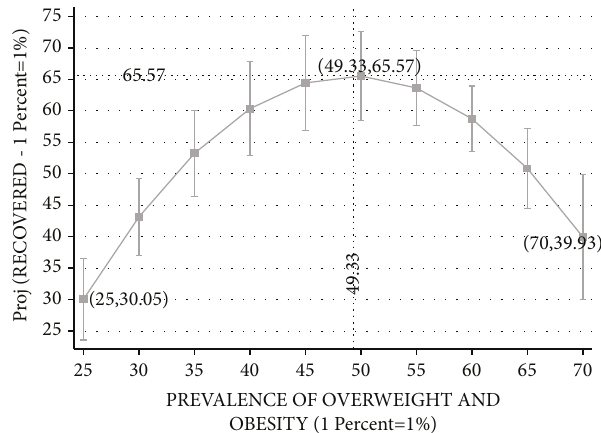
Figure 5: Rate of recovered COVID-19 patients vs. prevalence of overweight and obesity. The vertical axis measures the projected probability of recovery divided by total cases of COVID-19 in percentage points. The horizontal axis measures the prevalence of overweight and obesity (BMI ≥ 25, where BMI � kg/meter 2 ) in the population of OECD countries based on measured height and weight. The figure is based on the following regression outcomes given in column (1).